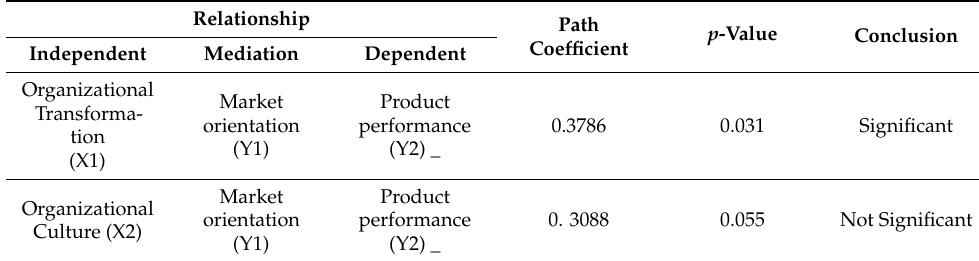
Table 4. Indirect Effect Hypothesis Test.